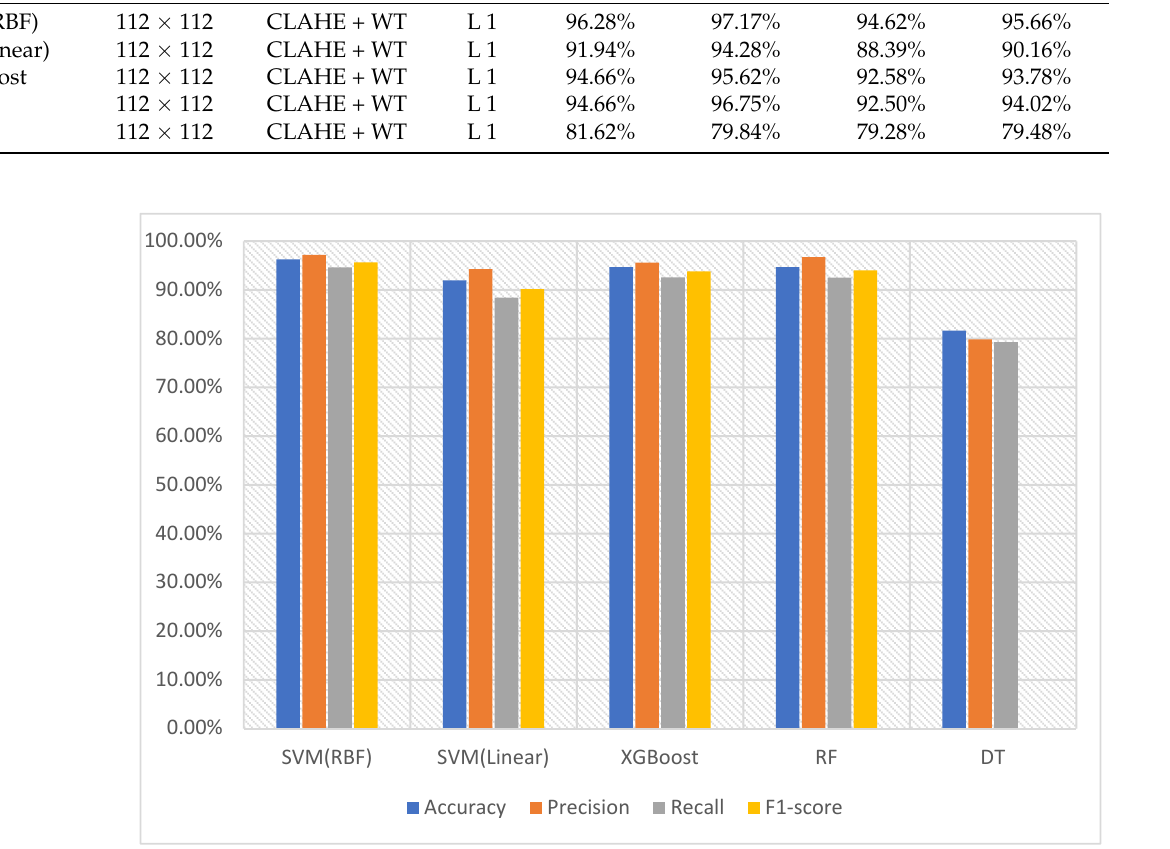
Figure 10. Comparison of the results of the machine learning classifiers on version 1 of the dataset.